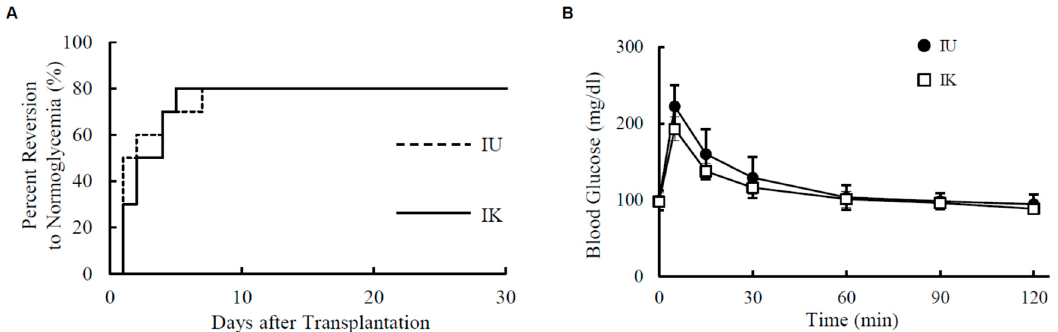
Figure 3. Islet transplantation into diabetic nude mice. ( A ) The percentage of streptozotocin (STZ)-induced diabetic nude mice in which normoglycemia was achieved after islet transplantation is shown. A total of 2000 IEs were transplanted below the kidney capsule of the diabetic nude mice. Normoglycemia was defined as two consecutive post-transplant blood glucose level measurements of < 200 mg / dL (IU group, n = 10; IK group, n = 10). ( B ) The results of the intraperitoneal glucose tolerance testing (IPGTT). Normoglycemic mice at 30 days after islet transplantation were fasted overnight and then intraperitoneally injected with glucose (2.0 g / kg body weight). Blood glucose levels were measured before and at 5, 15, 30, 60, and 120 min after glucose injection (IU group, n = 5; IK group, n = 5).